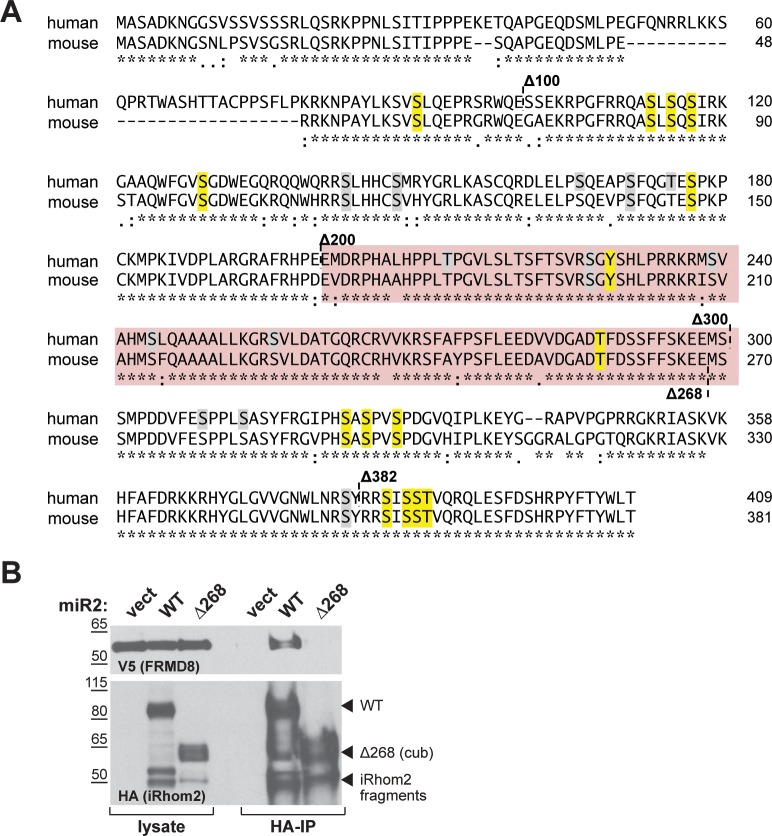
A) Amino acid sequence alignment of human and mouse iRhom2 N-terminal region using Clustal Omega.The region required for FRMD8 binding is highlighted in red. Conserved phosphorylation sites that have been mutated to alanine in the iRhom2pDEAD (Figure 10—figure supplement 1) are marked in yellow. Grey residues indicate additional phosphorylation sites that have been reported on PhosphoSitePlus (www.phosphosite.org). An asterisk (*) indicates positions which have a fully conserved residue, a colon (:) indicates strongly similar properties of the amino acids, and a period (.) indicates weakly similar properties according to the Clustal Omega tool. (B) Lysates and anti-HA immunoprecipitation (HA-IP) from HEK293T cells transiently transfected with FRMD8-V5 and either empty vector (vect), mouse iRhom2WT (WT) or Rhom2cub (Δ268) were immunoblotted for V5 and HA.